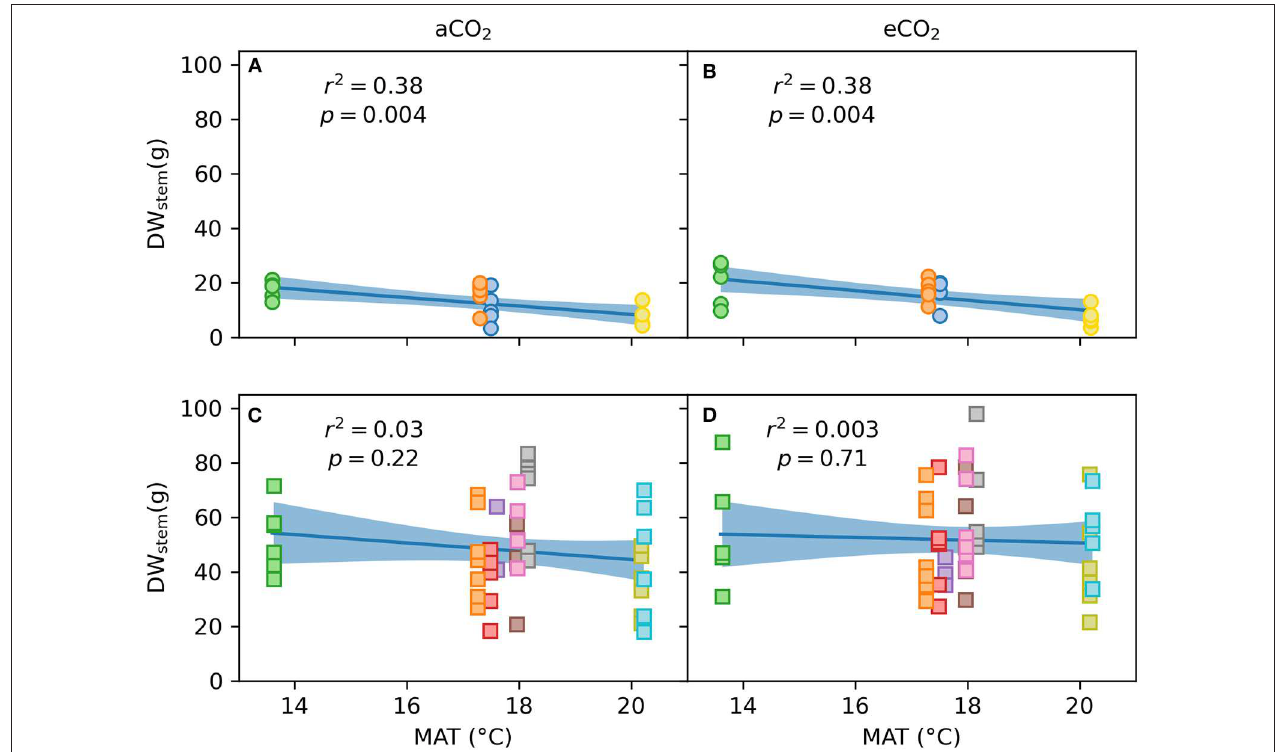
FIGURE 8 | Correlation between stem dry weight at harvest (DW stem ) and mean annual temperature (MAT) at seed origin for Experiment 1 and 2 for ambient (aCO 2 ; A,B ) and elevated [CO 2 ] (eCO 2 ; n = 3–7 per provenance and [CO 2 ] treatment; C,D ). Circles in (A,B) represent data of the four provenances in Experiment 1, squares in (C,D) represent data of the nine provenances in Experiment 2. Dark blue line shows linear fit of the data with light blue areas representing confidence intervals.